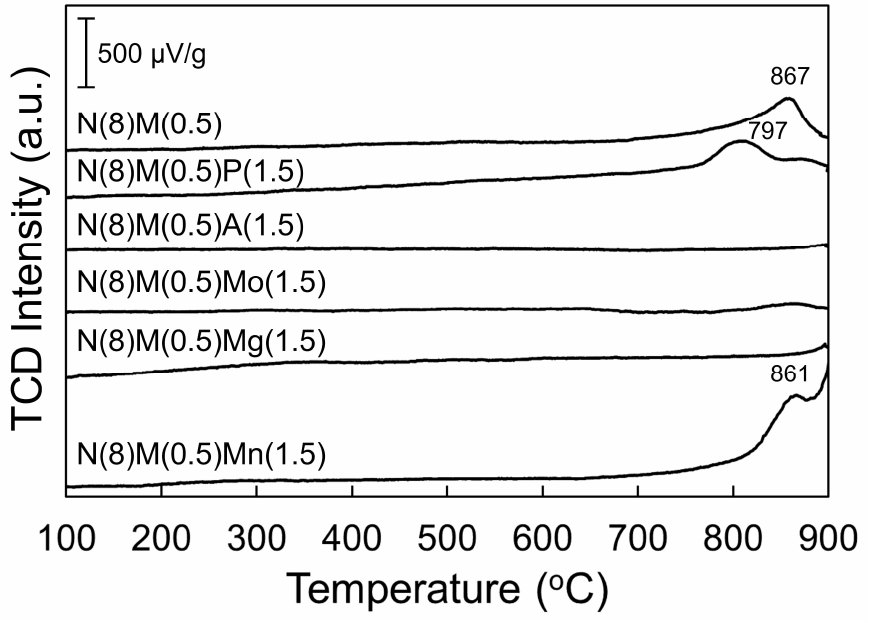
Figure 2. O 2 temperature-programmed desorption results of fresh catalyst pellets containing different inorganic binders.